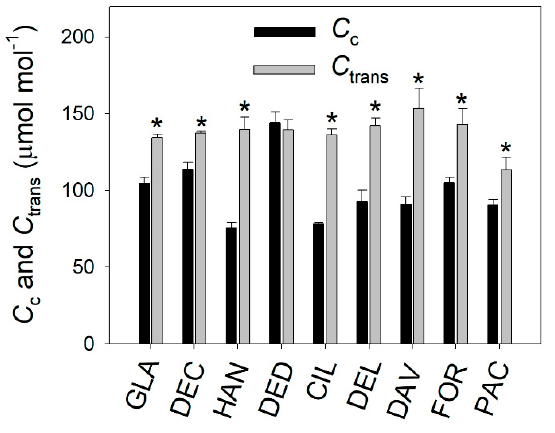
Figure 7. Comparison of C c and C trans at 1500 µ mol photons m − 2 s − 1 in nine Rhododendron species. Symbols represent means ± SE ( n = 4–5). Significant differences at a 5% confidence level are indicated with an asterisk. Species abbreviations: DEC, R. decorum ; GLA, R. glanduliferum ; HAN, R. hancockii ; DED, R. decorum subsp. disprepes ; CIL, R. ciliicalyx ; DEL, R. delavayi ; DAV, R. davidii ; FOR, R. fortunei ; PAC, R. pachypodum .